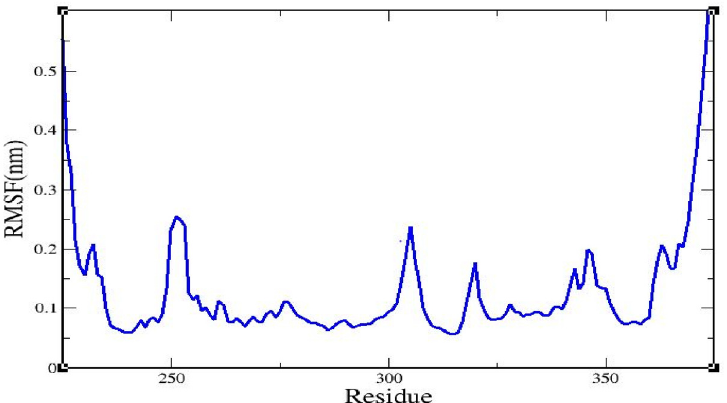
Figure 3. The root mean square fluctuation of the caspase 8/rutaecarpine complex.